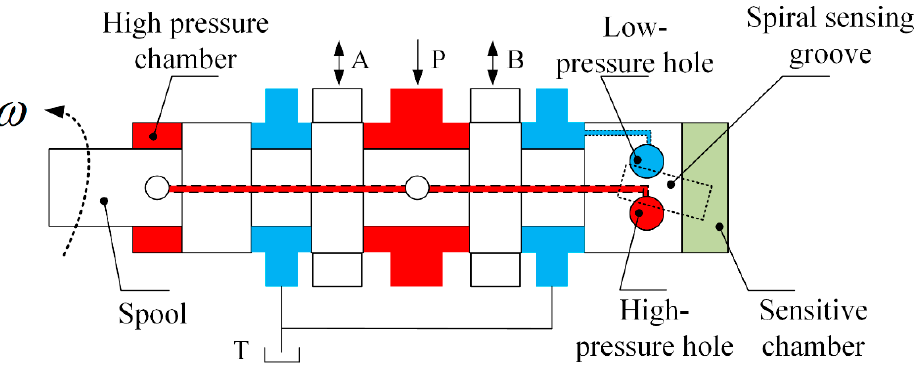
Figure 1. Working principle diagram of 2D valve.